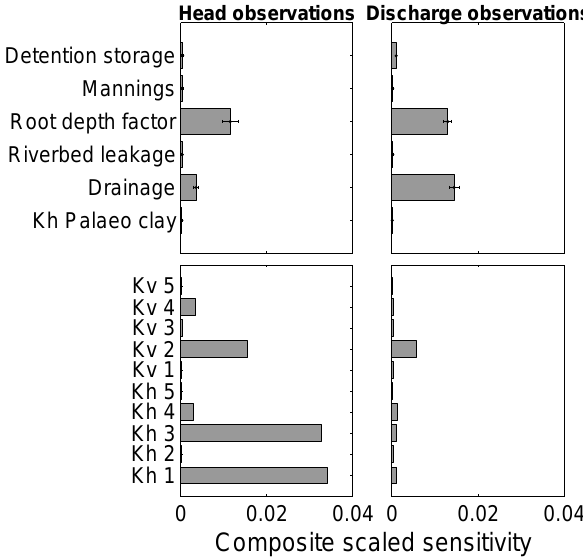
Figure 5. Composite-scaled sensitivity values of selected parame- ters in the hydrological model. Sensitivities are shown for head and discharge observation separately. The two top plots show average, minimum, and maximum sensitivity of the 11 hydrostratigraphic cluster models. The two lower plots show sensitivity of subsurface parameters given a 5-cluster model. K h is horizontal hydraulic con- ductivity and K v is vertical hydraulic